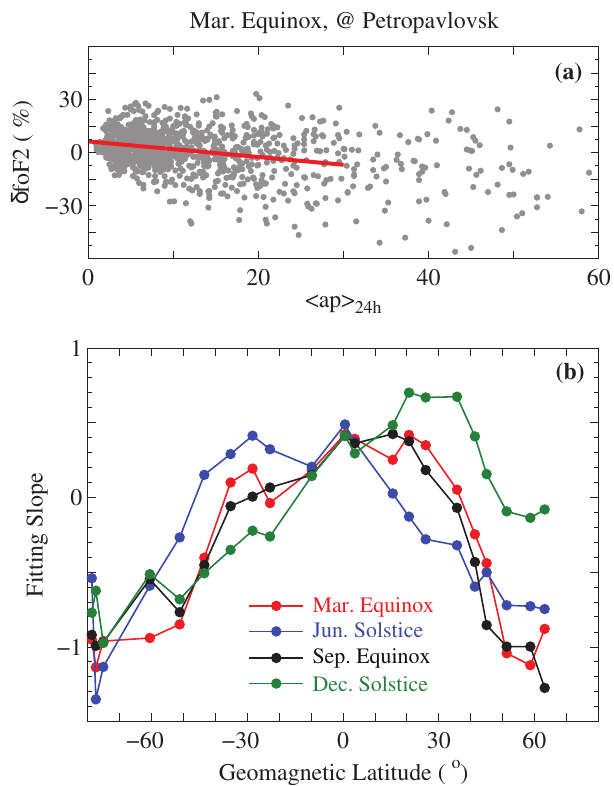
Fig. 8. (a) Scatter plots of the percentage deviation of observed f o F 2 from the fi tted values, d f o F 2 , versus < ap > 24 h at Petropavlovsk in March equinox season; the red line is the linear fi tting of the dots for the geomagnetic activity level of < ap > 24 h <30. (b) Latitude variations of the fi tting slope of d f o F 2 versus < ap > 24 h ; the red, blue, black, and green lines correspond to the seasonal conditions of March equinox, June Solstice, September equinox, and December solstice,